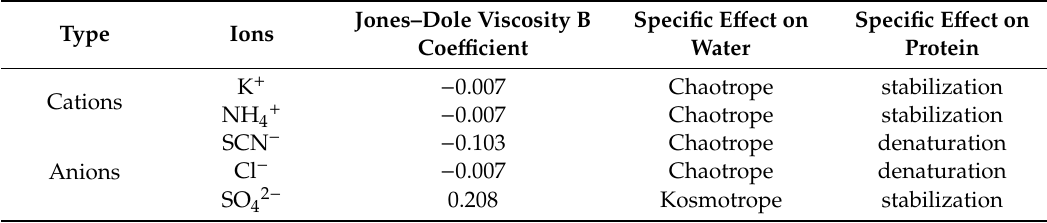
Jones–Dole Viscosity B Specific E ff ect on Specific E ff ect on Type Ions Coe ffi cient Water Protein K + − 0.007 Chaotrope stabilization Cations NH 4 + − 0.007 Chaotrope stabilization SCN − − 0.103 Chaotrope denaturation Cl − − 0.007 Chaotrope denaturation Anions SO 42 − 0.208 Kosmotrope